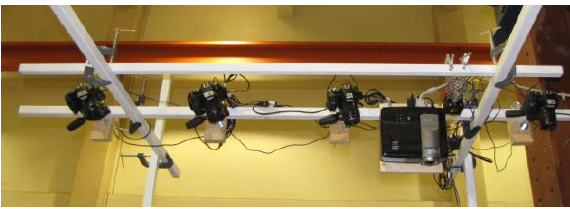
Figure 4. Example of the multiple camera and projector setup on one side of the built metal frame